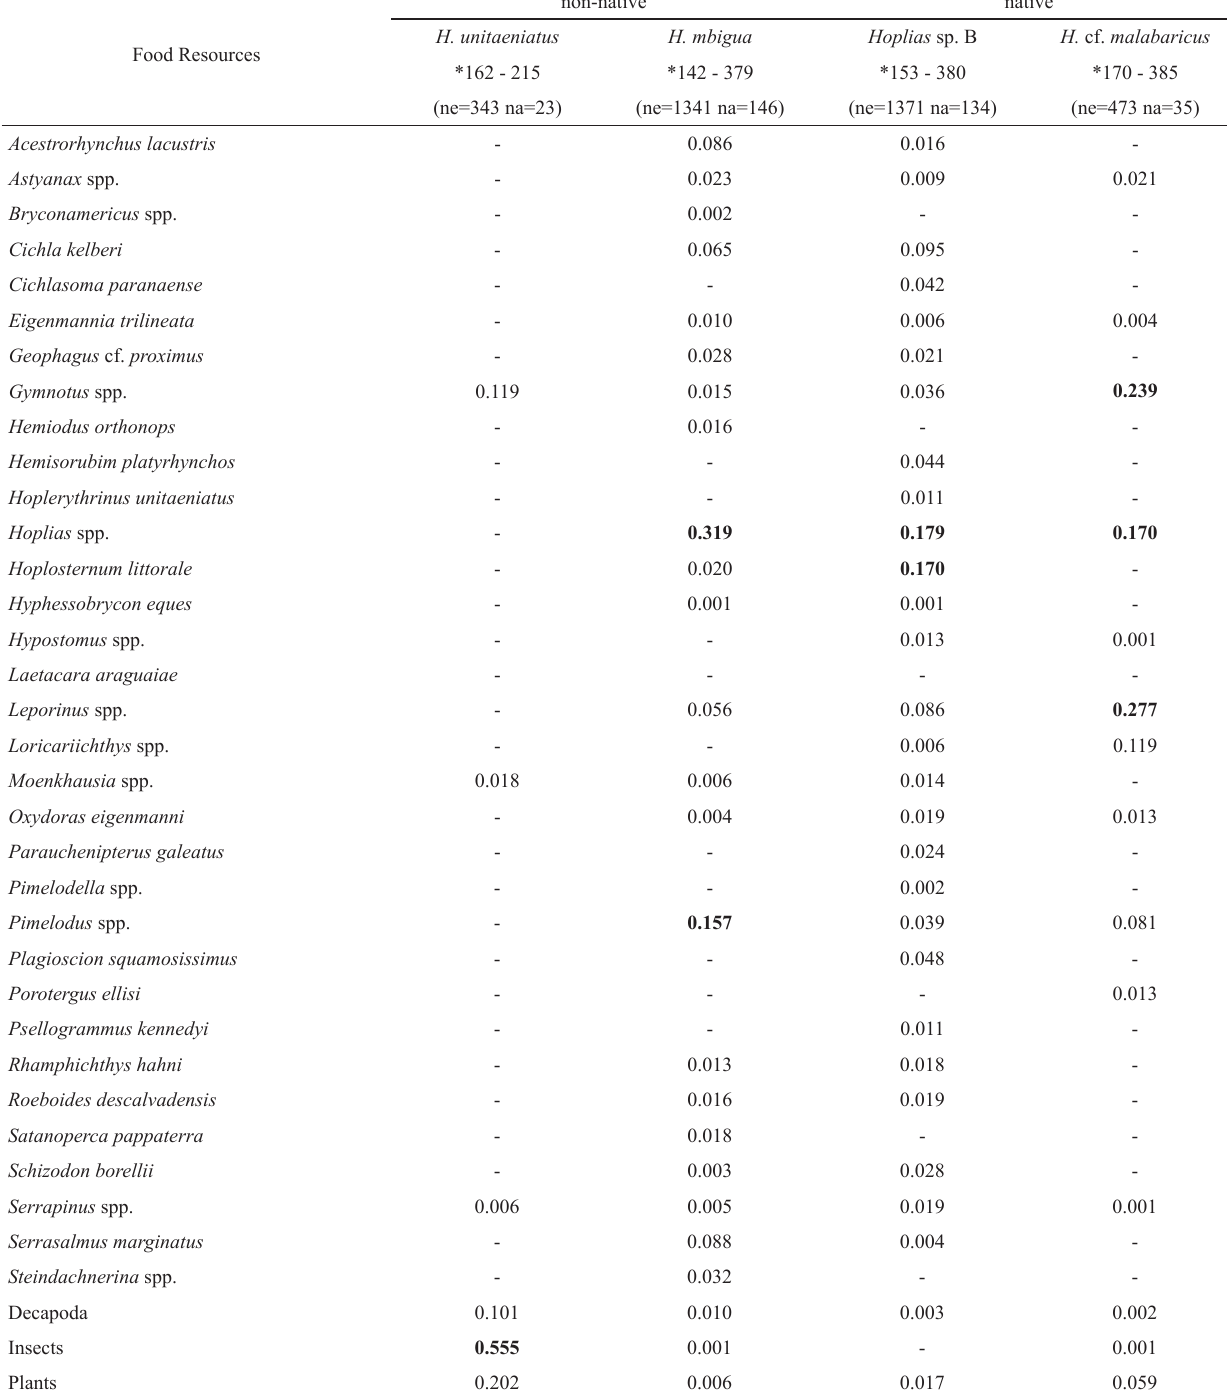
Tab. 4. Diet composition (in volume percentage - %V) of non-native ( H. mbigua and H. unitaeniatus ) and native ( Hoplias sp. B and H. cf. malabaricus ) Erythrinidae species in the upper Paraná River floodplain. Bold values indicate the food resources with the highest %V for each species. ne=number of empty stomachs (excluded from the analyses). na=number of analyzed stomachs. *Minimum and maximum size of analyzed individuals